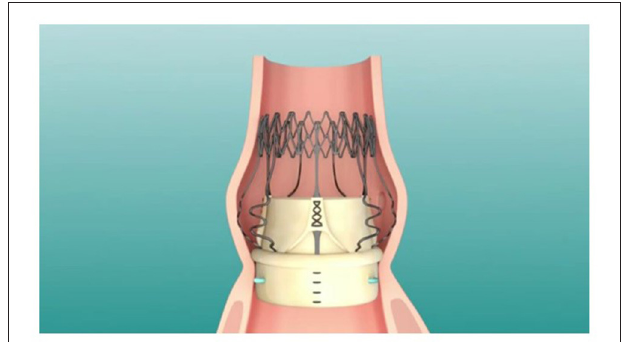
FIGURE 2 | Sutureless aortic valve in the aortic annulus.